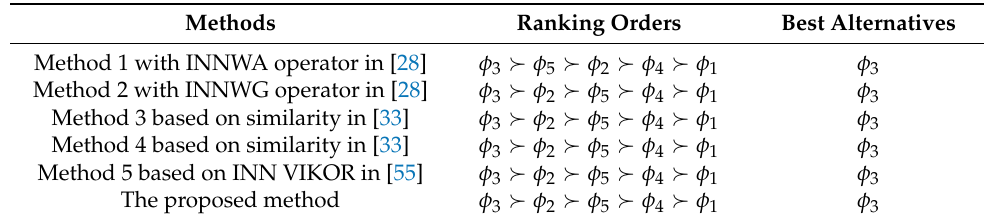
Table 5. The orders by utilizing five